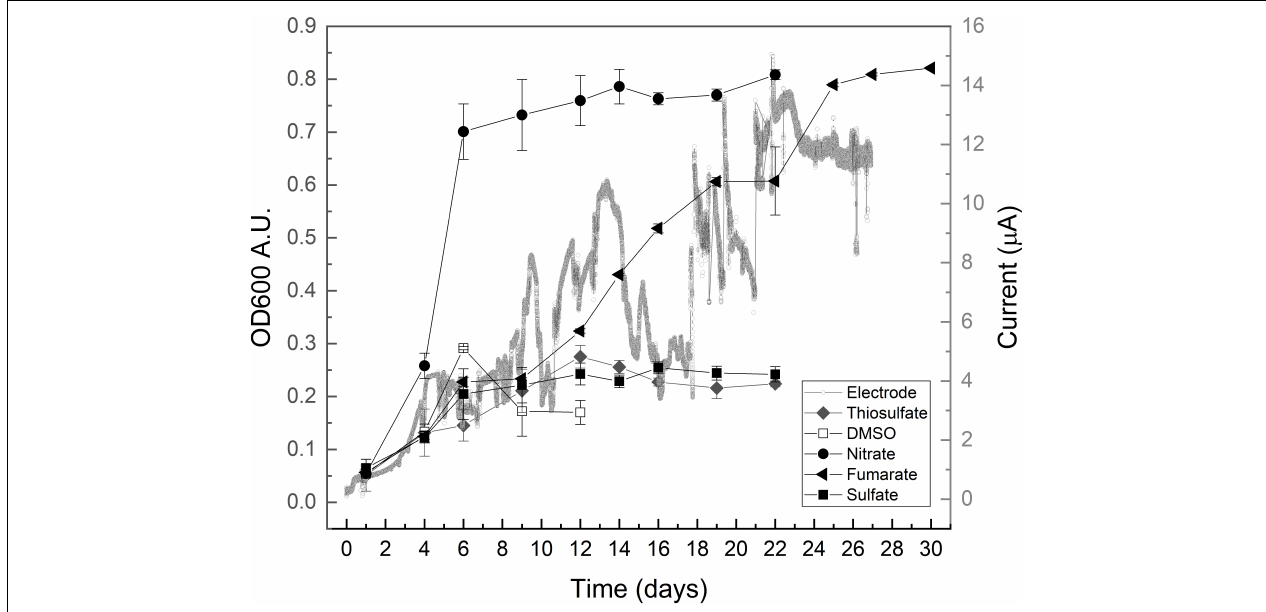
FIGURE 1 | Growth profiles obtained on lactate and the indicated electron acceptors after inoculating with consortium enriched on lactate/fumarate couple. OD 600 data are presented as media ± standard deviation ( n ≥ 3). A typical chronoamperometry curve is presented.